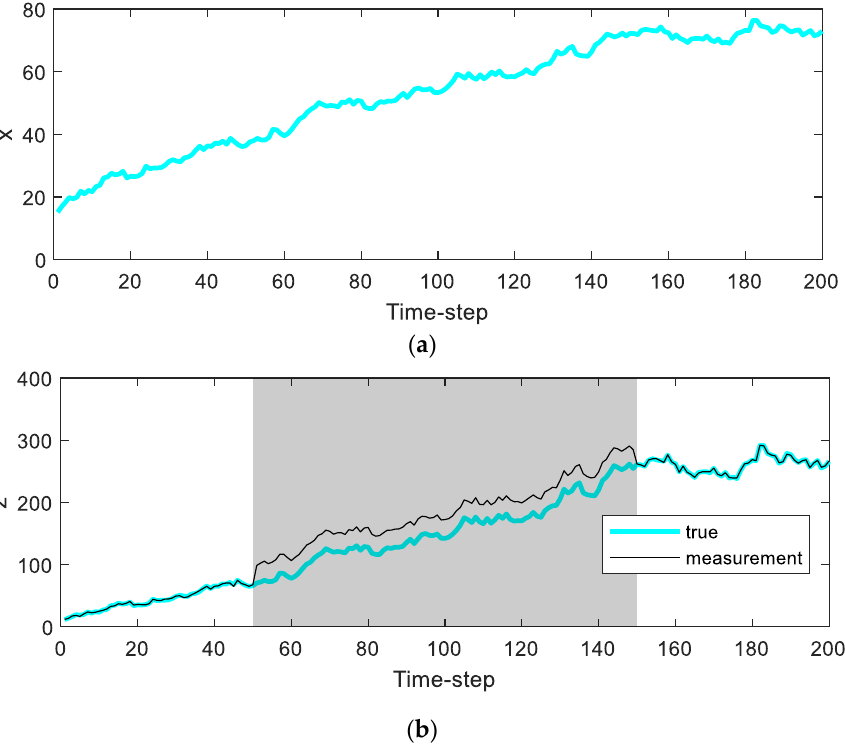
Figure 1. True trajectories of the simulation: ( a ) the true value of x n in the simulation; ( b ) the true value of z n and z n with bias error in the gray-colored period.